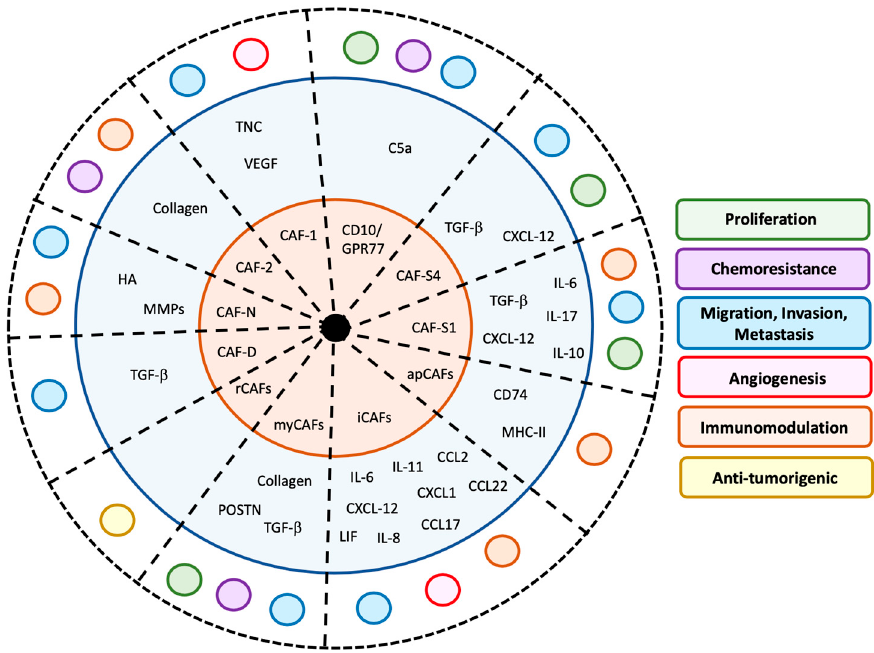
Figure 2. Heterogenous Function and Phenotype of Cancer-Associated Fibroblasts. The inner circle lists subtypes of CAFs reported by various groups of investigators. The middle circle indicates markers and proteins secreted by each subtype and in the outer circle, the functions attributed for each subtype are indicated by the colored circles representing one among the six CAF functions listed in the margin.